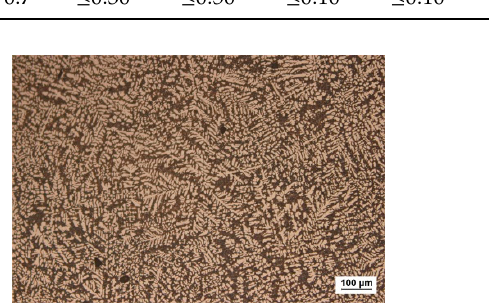
Figure 1. Microstructure of 55 vol.% SiC p /ZL102 composites.